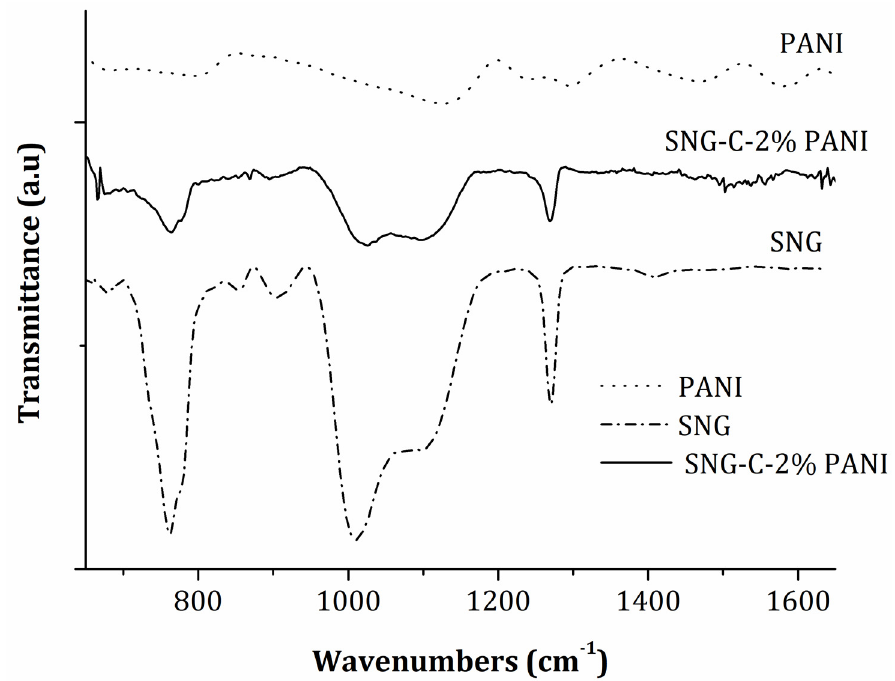
Figure 2. FTIR spectra recorded with different conducting materials: (dotted line) PANI, (dashed line) SNG–C–2% PANI and (solid line) SNG.